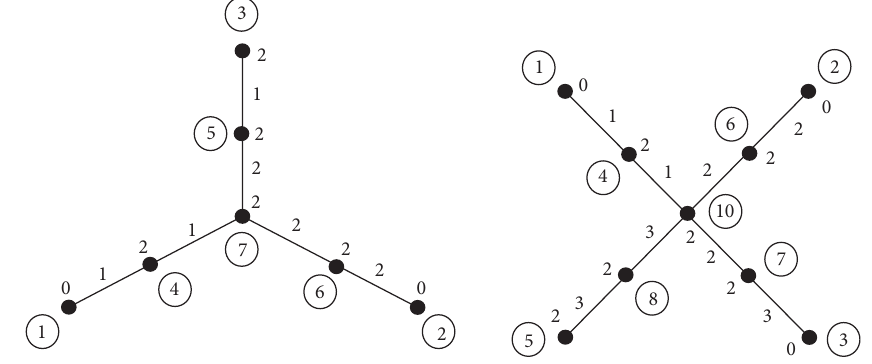
Figure 2: The illustration of labeling on SS